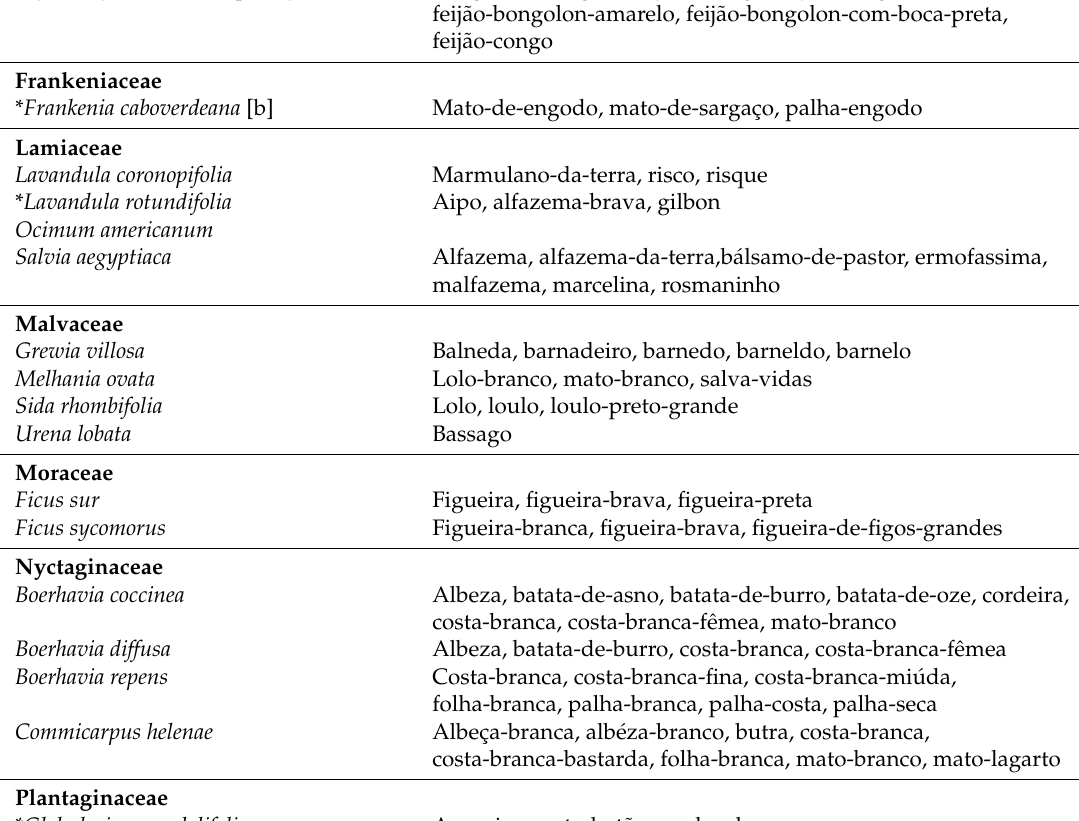
Figueira, figueira-brava, figueira-preta Fd,Fr,T • Figueira-branca, figueira-brava, figueira-de-figos-grandes